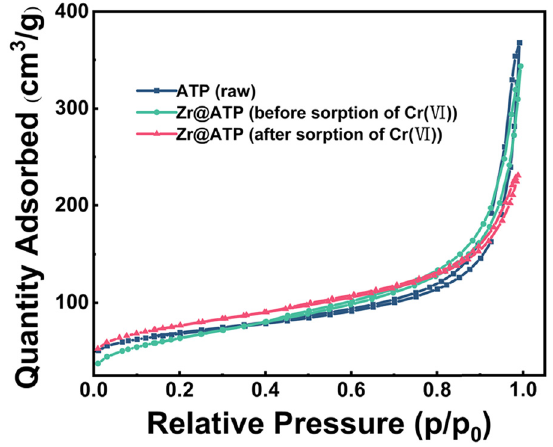
Figure 3: N 2 adsorption – desorption isotherms for ATP, Zr@ATP, as well as Zr@ATP after adsorbing Cr ( VI ) .